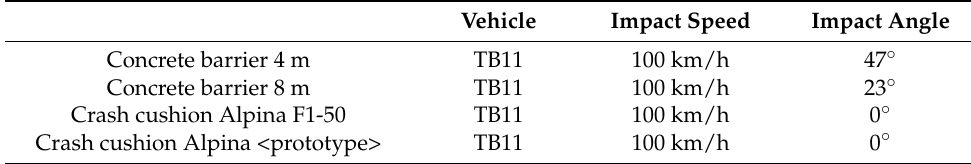
Table 3. Test matrix of the performed